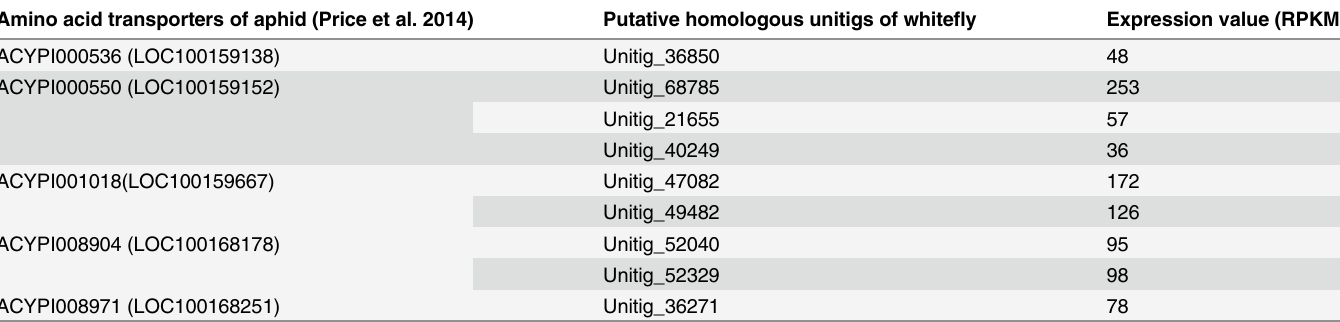
Table 3. Expression value of the putative homologous unitigs in whitefly for the top five amino acid transporters of aphid. Amino acid transporters of aphid (Price et al.